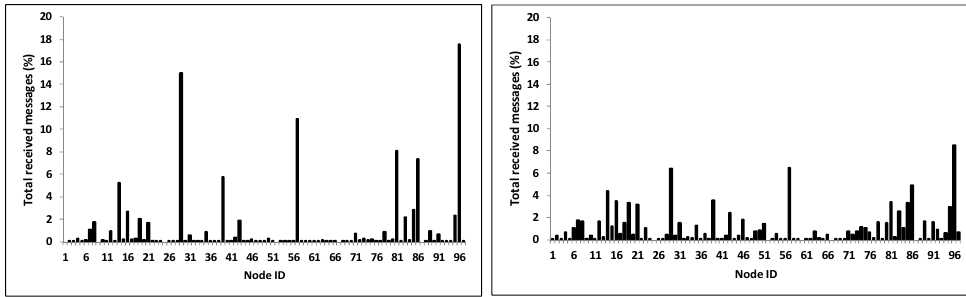
Figure 10. ( left ) The traffic load distribution among nodes in Reality for BubbleRap, and ( right ) for Bubble-TLDA ( ξ = 0.8, F th = 150 ks). Clearly, the improved node popularity calculation of TraLDA on BubbleRap significantly reduces the traffic load in the hub nodes, while increasing the relay traffic in majority of non-hub nodes.